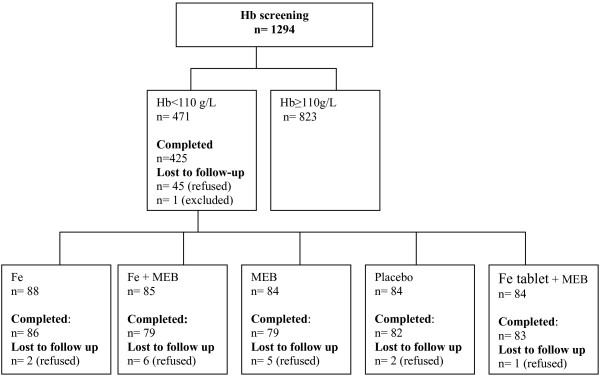
Study profile: initial screening to enroll anaemic children in the study, followed by a 6 month intervention.